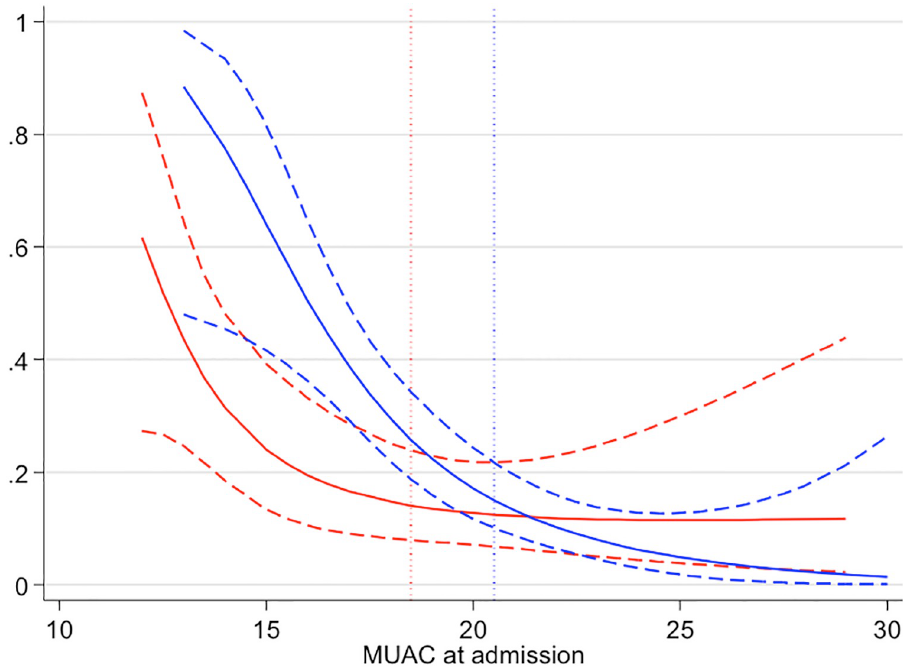
Fig 2. Predicted probability of death by MUAC at admission from unadjusted fractional polynomial logistic regression. Red = females, blue = males, dotted lines are sex specific MUAC cut-off values for under-nutrition.